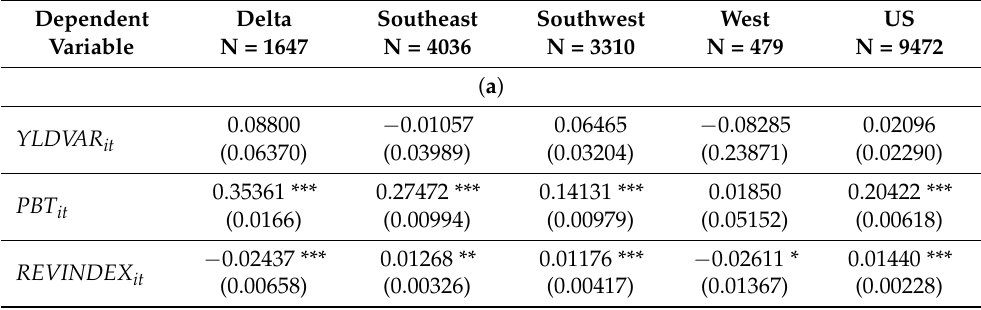
Table 3. (a) Marginal effects on insurance participation ( PINSUR ). (b) Marginal effects on percent cotton planted ( PCOTACRES